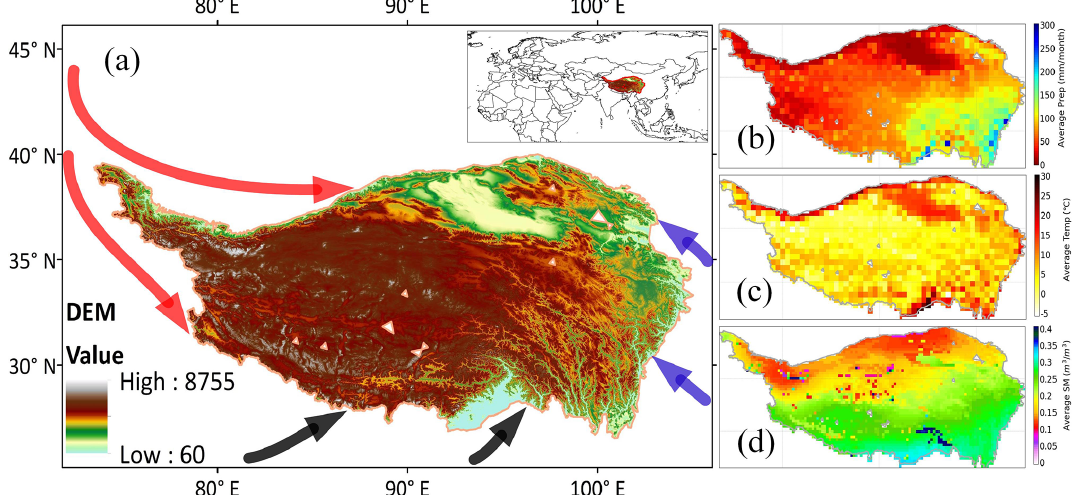
Figure 1. (a) Location of the Tibetan plateau (TP) and the elevation, (b) monthly average precipitation (Prep), (c) air temperature (Temp), and (d) soil moisture (SM) over the summer period (May–September). Prep and Temp are based on the gauging interpolation data provided by the Chinese Meteorological Administration (CMA). SM is from the Noah model driven by the Global Land Data Assimilation System (GLDASv2.0/Noah) dataset with a depth of 0–10cm. The black, red, and blue arrows represent the Indian monsoon, the westerlies, and the East Asian monsoon,